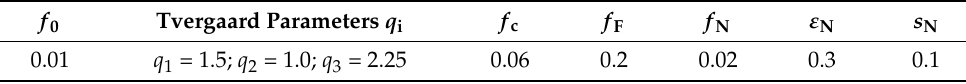
Table 3. GTN material parameters introduced to numerical